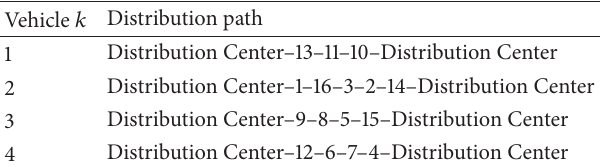
Table 8: The distribution path figure of DNA-ant colony algorithm. Vehicle 𝑘 Distribution path